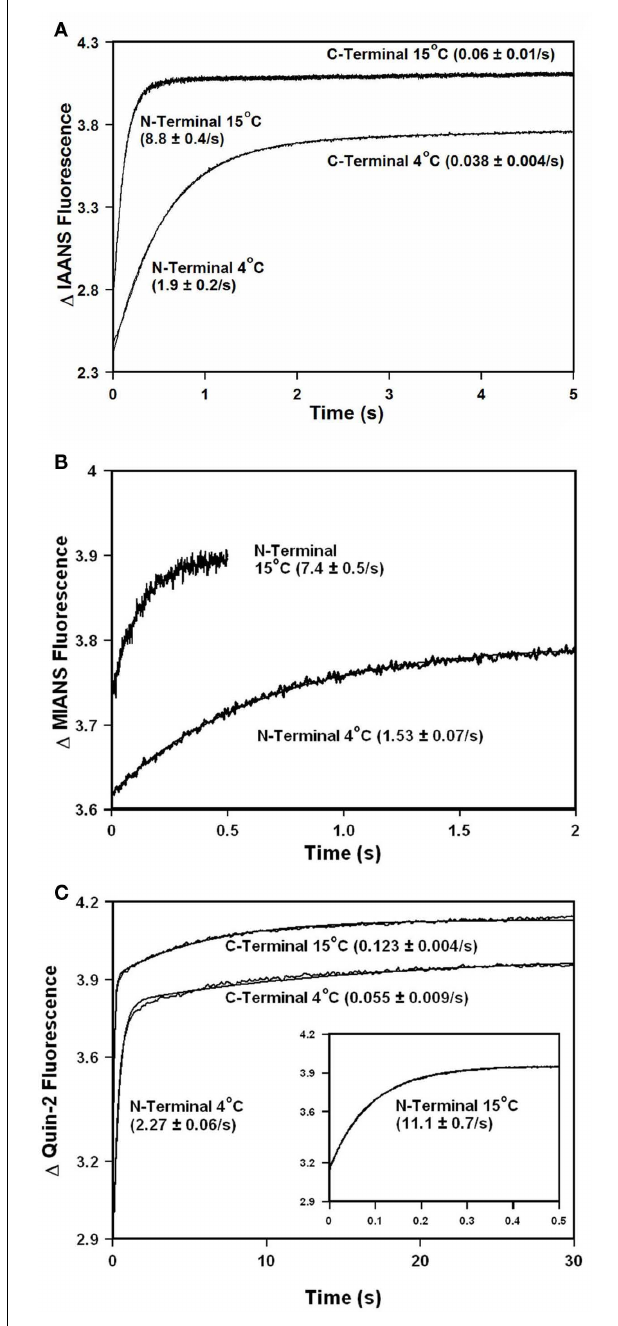
FIGURE 5 | Comparison of calcium dissociation kinetics from TnC T54C,C101S TnC T54C,C101S andTnC T54C,C101S in the presence ofTnI. (A) Shows IAANS , MIANS , the time course of increase in IAANS fluorescence as Ca 2 + was removed by EGTA from the N-terminal regulatory and C-terminal structural Ca 2 + -binding sites of theTnC T54C,C101S –TnI complex.TnC T54C,C101S (0.6 μ M) plusTnI (1.2 μ M) IAANS IAANS in 10mM MOPS, 90mM KCl, 1mM Mg 2 + , 1mM DTT at pH 7.0 plus 200 μ M Ca 2 + was rapidly mixed with an equal volume of the same buffer plus 10mM EGTA at 4 and 15˚C. IAANS emission fluorescence was monitored as described in the legend of Figure 4A . (B) Shows the time course of increase in MIANS fluorescence as Ca 2 + was removed by